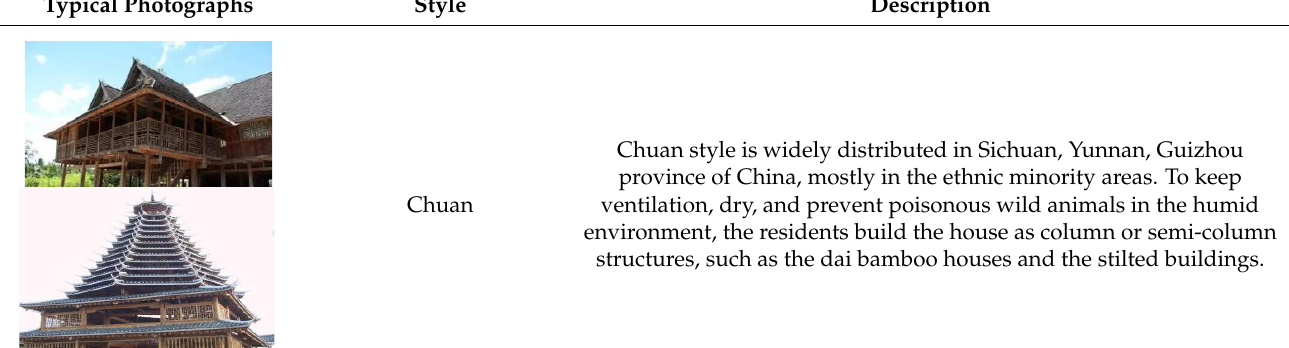
Table 1. Typical photographs and detailed descriptions of the six selected architectural styles.